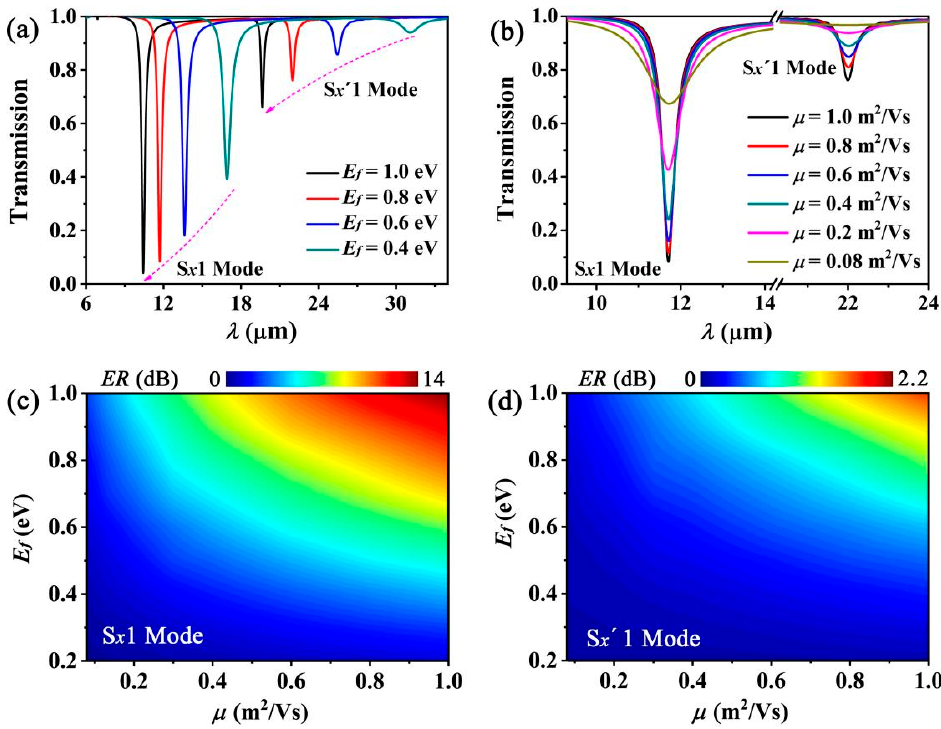
Figure 4. ( a , b ) show the simulated transmission spectra at different E f and μ values, respectively. ( c , d ) show the extinction ratio ( ER ) of the S x 1 and S x ′ 1 modes with varying E f and μ values, respec- ( c , d ) show the extinction ratio ( ER ) of the S x 1 and S x (cid:48) 1 modes with varying E f and µ values, tively.